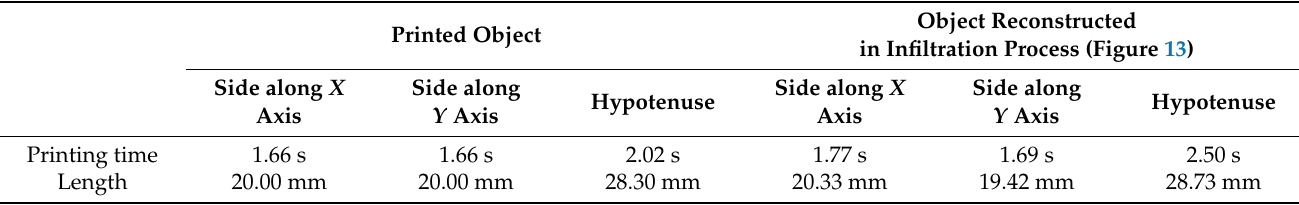
Table 1. The reproduction accuracy of the trihedron (Figure 7a).